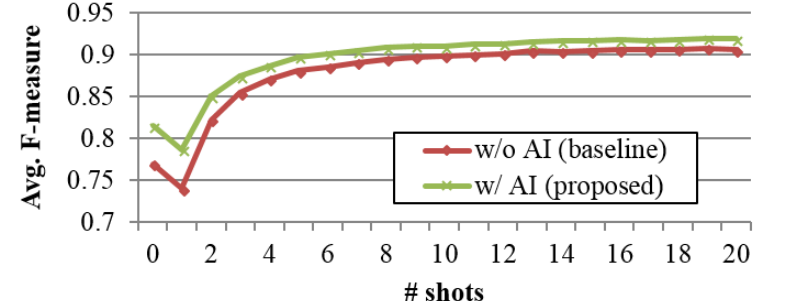
Figure 4. The results of few-shot